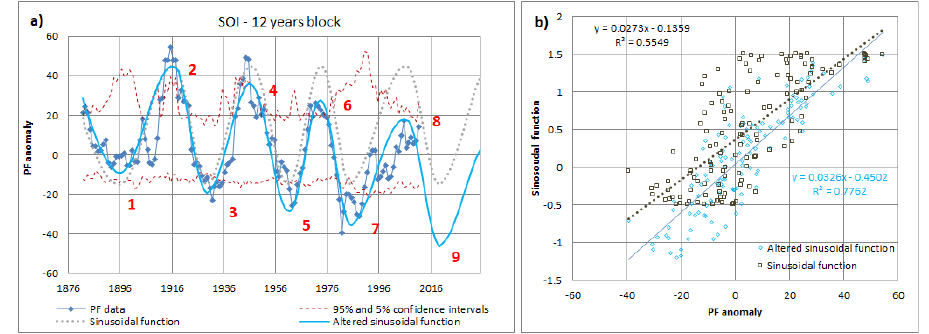
Figure 4. ( a ) Sinusoidal approximation of the QPM climate anomaly based on SOI data; ( b ) Goodness- of-fit evaluation of the original and altered sinusoidal approximation.